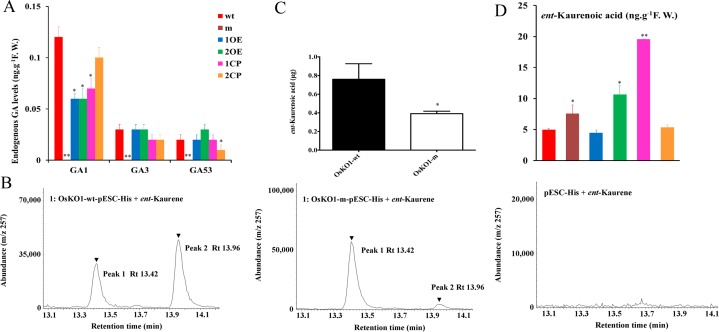
GA contents and OsKO1 enzyme activity analyses.(A) Endogenous GA1, GA3 and GA53 contents in the embryos of different rice lines. (B) Yeast expression and GC-MS analysis of enzyme activity of normal OsKO1 (left panel) and mutated OsKO1 (middle panel), with empty vector pESC-His transgenic yeast as negative control (right panel). GC-MS chromatograms at single ion 257 showed products ent-kaurenol (peak 1) and ent-kaurenoic acid (peak 2) catalyzed by OsKO1 from ent-kaurene. The right panel. (C) Quantitative analysis on the production of ent-kaurenoic acid between normal OsKO1 and mutated OsKO1 in the transgenic yeast system. Data are means±SE (n = 3). (D) Endogenous content of ent-kaurenoic acid in one-month-old seedlings of different rice lines. Wild-type (wt), mutant (m) and transgenic lines in mutant background. 1OE, OsKO1 gene overexpression lines; 2OE, OsKO2 overexpression lines; 1CP, OsKO1 gene native promoter transgenic lines; 2CP, OsKO2 gene native promoter transgenic lines. Significant difference was determined by Student’s t-test (*p < 0.05, **p < 0.01).